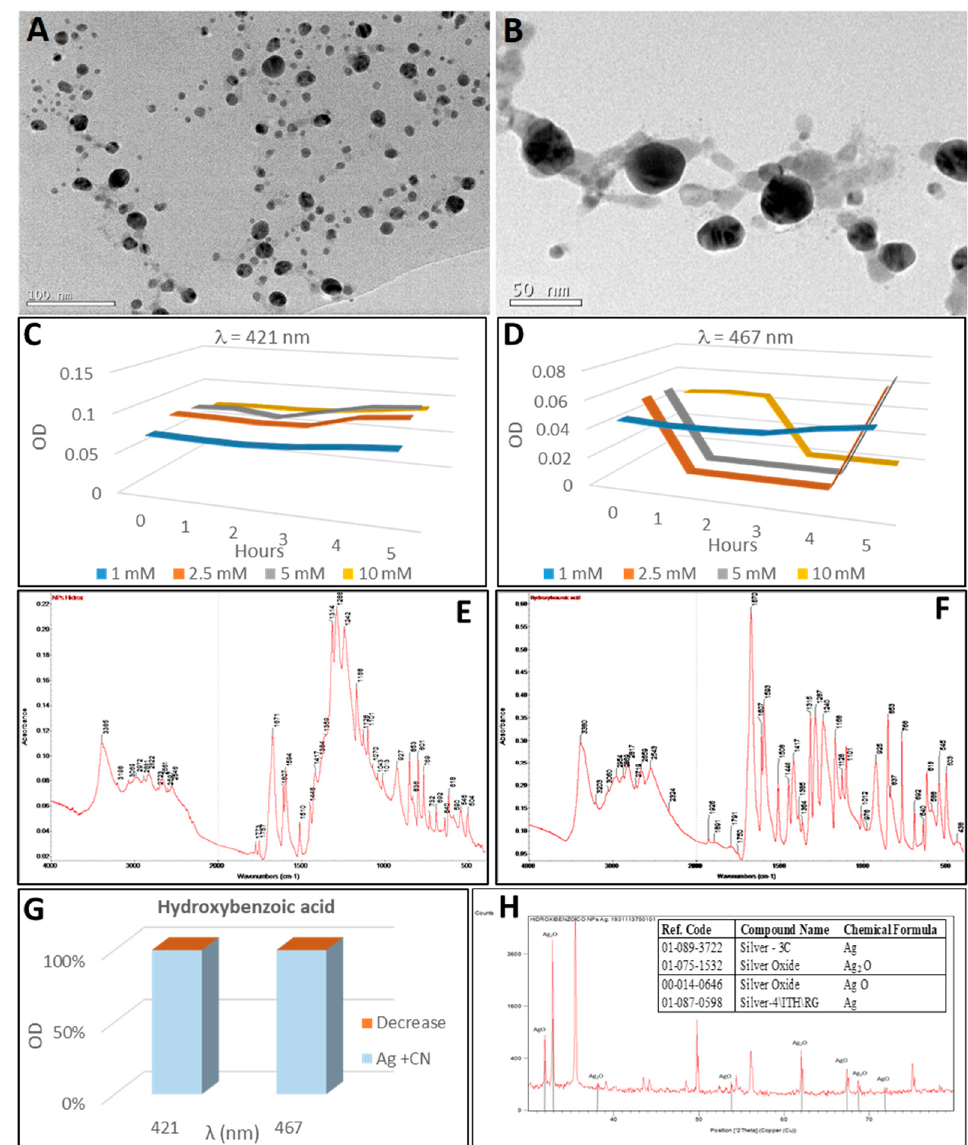
Figure 7. Analysis of silver nanoparticles synthesised with hydroxybenzoic acid. ( A ) TEM image of AgNPs prior to treatment with cyanide. ( B ) image of AgNPs after treatment with cyanide. ( C , D ) Synthesis of silver nanoparticles by the reaction of different AgNO 3 concentrations with hy- droxybenzoic acid for 5 h (in one-hour intervals). ( C ) maximum at wavelength 421 nm (50 nm diameter nanoparticles). ( D ) maximum at wavelength 467 nm (80 nm diameter nanoparticles). ( E ) FTIR spectrum of hydroxybenzoic acid-derived nanoparticles. ( F ) FTIR spectrum of hydroxyben- zoic acid. ( G ) Relative reduction of OD after cyanide addition to silver nanoparticles. ( H ): XRD profile of the AgNPs obtained by the reaction of hydroxybenzoic acid with AgNO 3 ; in the insert, the table with the identifications. Peaks identifying the presence of silver oxides have been indicated in the XRD